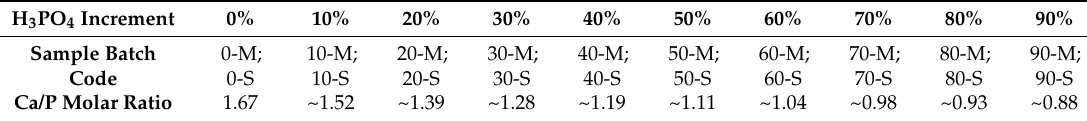
Table 1. Denomination of samples and Ca/P molar ratios of the precursor